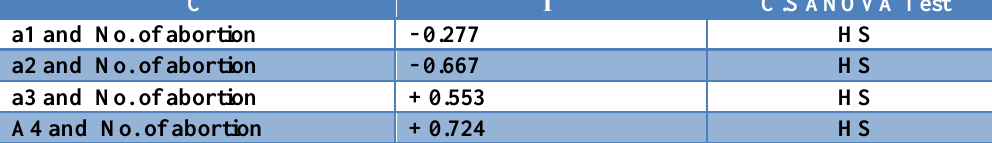
Table, 2: Correlations between samples number (enzymes) and No. of abortions C Γ C.S ANOVA